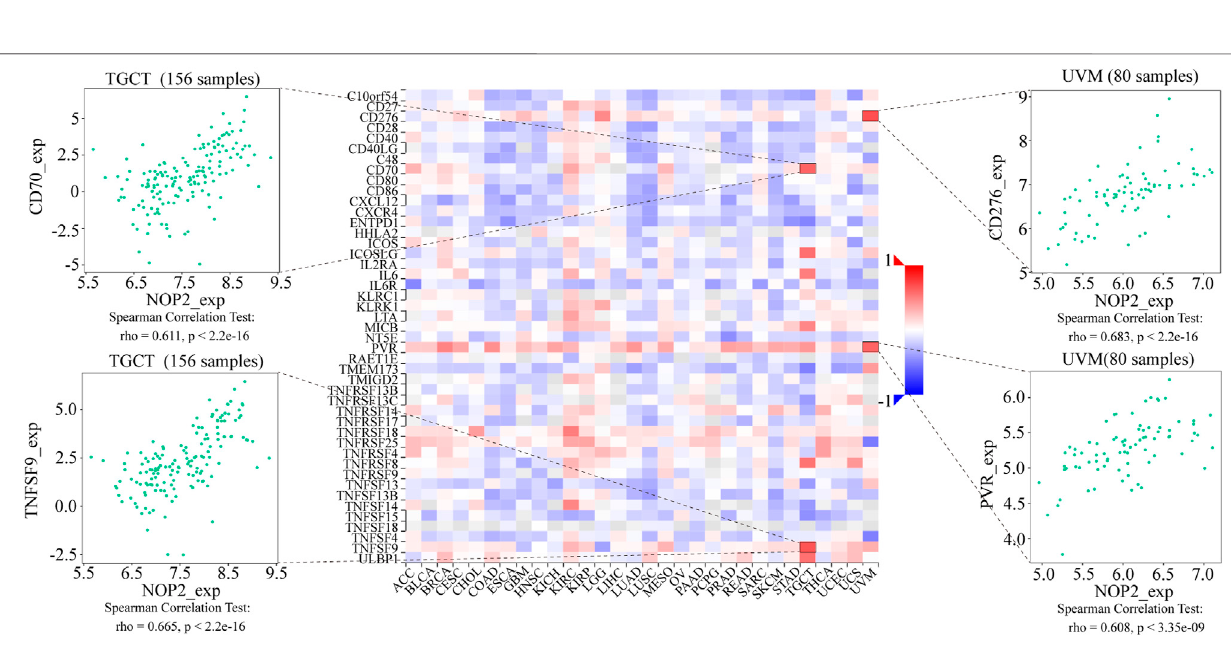
Frontiers in Cell and Developmental Biology |